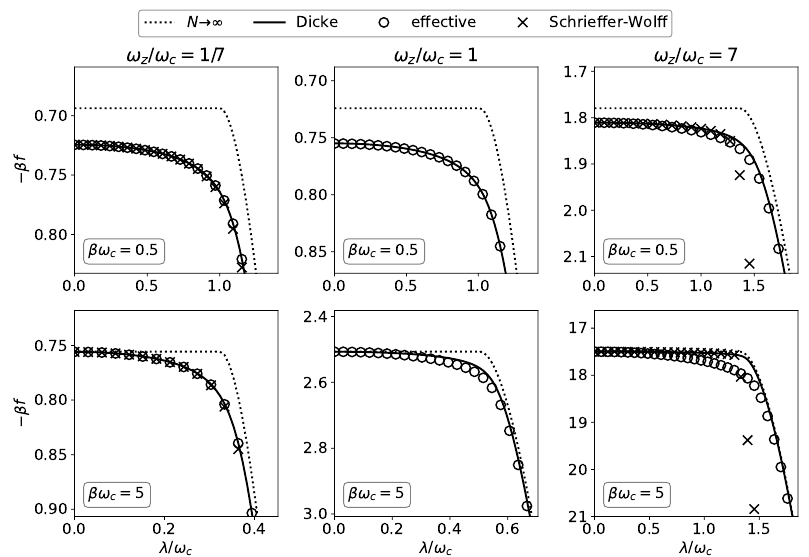
Figure 2: Comparison of the free energy per site computed by exact diagonalization of our effective Hamiltonian, exact diagonalization of the Schrieffer-Wolff Hamilto- nian, exact diagonalization of the Dicke model in the Polaron frame and the exact analytical solution in the thermodynamic limit. The system size is N = 30 and the = 100 cutoff is N ph